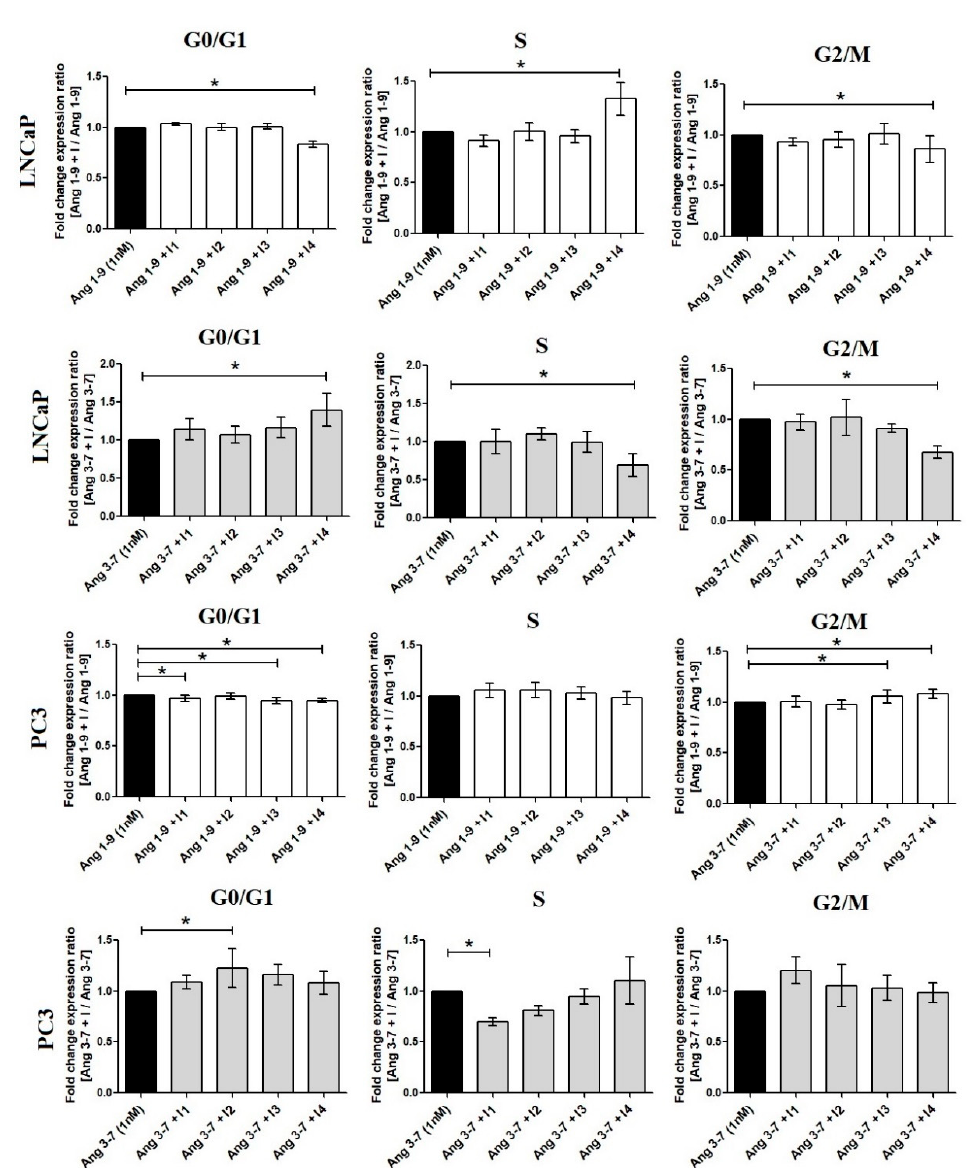
Figure 4. The Muse Cell Cycle Assay results showing the impact of angiotensin receptor inhibitors on Ang-(1-9) and Ang-(3-7) (1 nM) activity in prostate cancer cells: LNCaP and PC3. (I1: AT1 inhibitor—losartan; I2: AT2 inhibitor—PD123319; I3: AT1–7 / MAS inhibitor—A779; I4—AT4 / IRAP inhibitor—HFI142; 1000 nM) (Dunnett’s test; * p < 0.05).